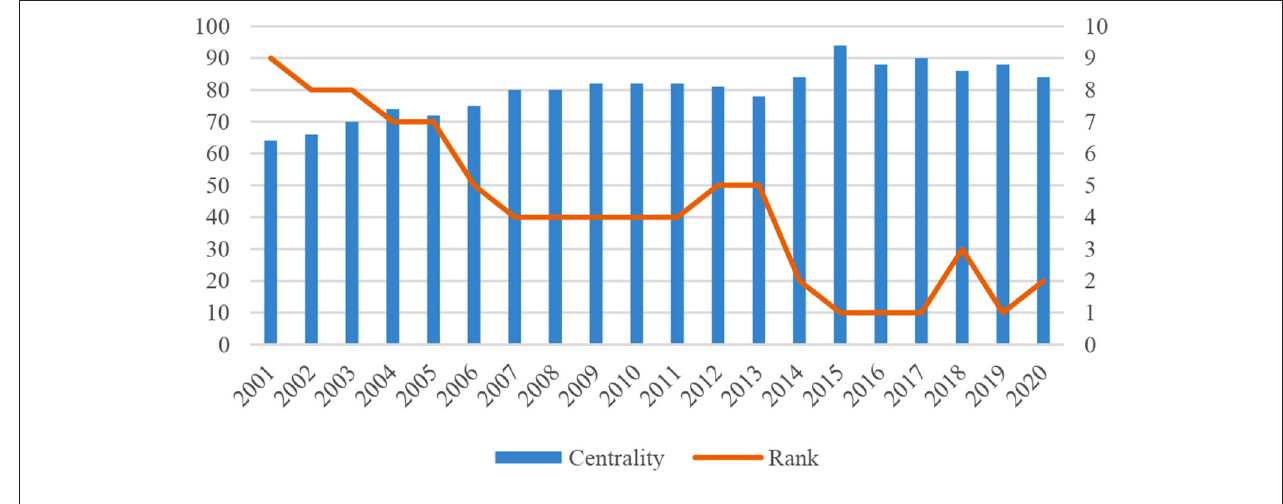
FIGURE 6 | China’s network centrality and rank from 2001 to 2020.